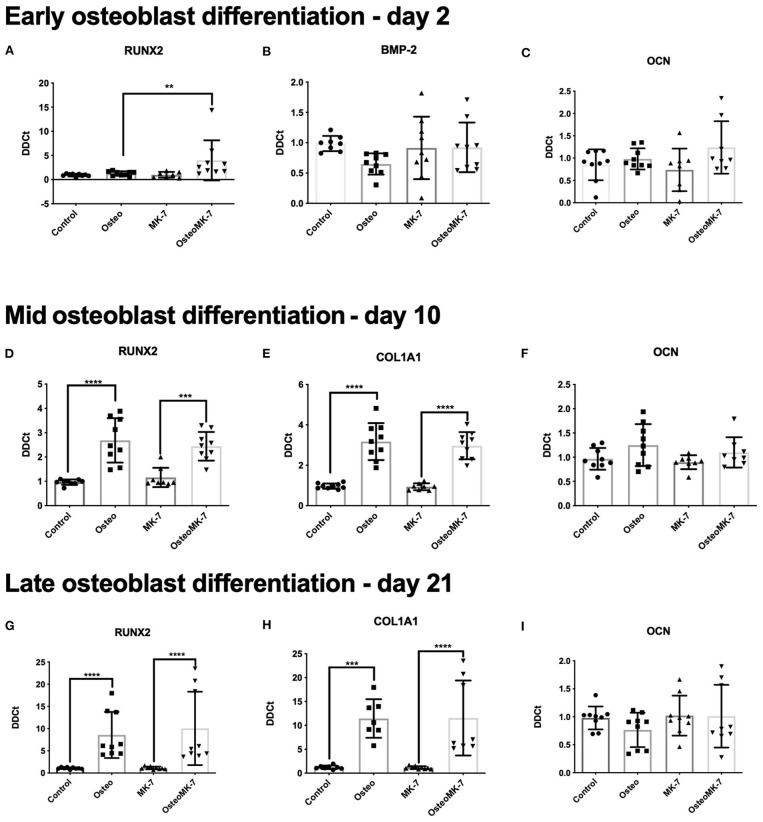
RT-qPCR expression of markers at various time points in differentiation. RT-qPCR of RUNX 2 (A,D,G) at various time points reveals its upregulation from controls as early as timepoint day 2 wherein RUNX2 is significantly upregulated under OsteoMK7 compared to controls and Osteo (p = 0.0040). At earliest timepoint BMP2 expression was not modulated between any treatments (B). COL1A1 (E,H) is significantly upregulated in osteogenic differentiation from day 10 (p < 0.0001). However, osteocalcin (C,F,I) has no differences in expression via any of the treatment over any time point in the differentiation. **p < 0.01, ***p < 0.001, ****p < 0.0001.